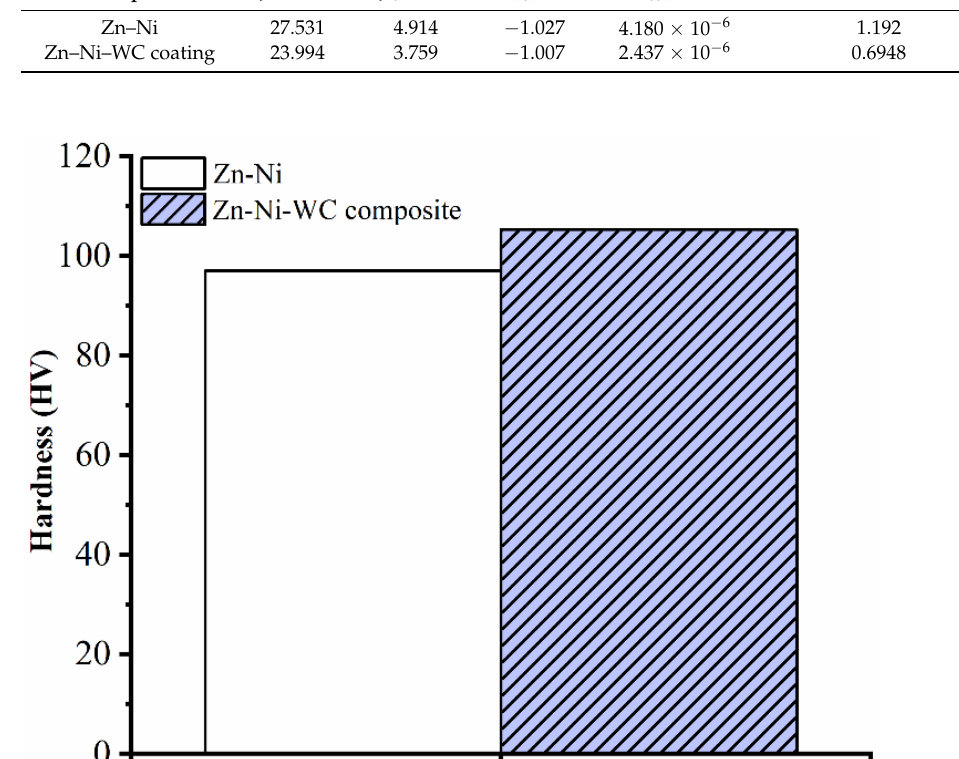
Figure 9. Vicker’s microhardness for electrodeposited coatings (Zn–Ni alloy and Zn–Ni–WC com- posites).